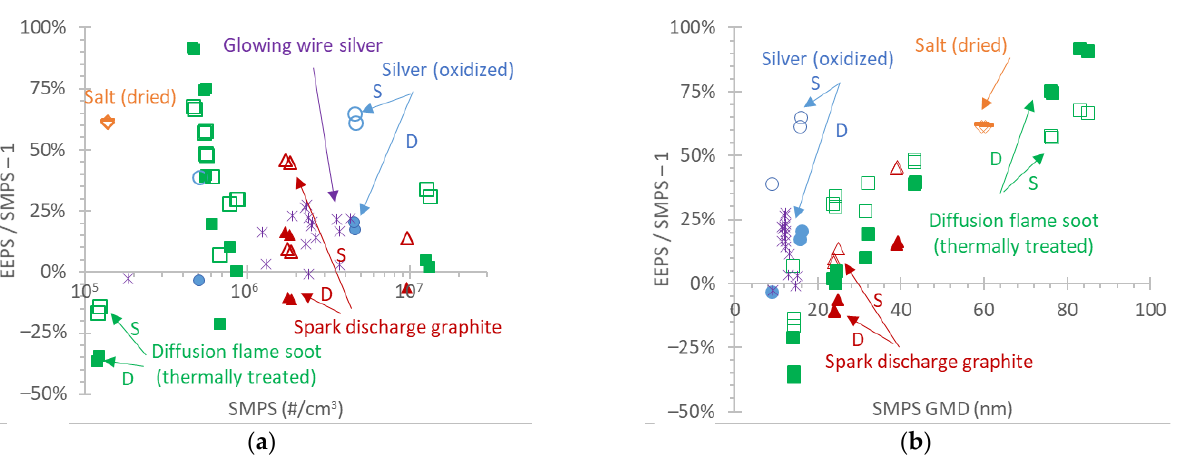
Figure 6. PN concentration ratio (EEPS to SMPS) in function of: ( a ) the SMPS concentration; ( b ) geometric mean diameter (GMD) of SMPS. “D” refers to the “Default” EEPS matrix (solid symbols), “S” refers to the “Soot” EEPS matrix (open symbols). Figure 7a correlates the GMDs of the SMPS and the EEPS with the “Default” (solid symbols) and the “Soot” (o pen symbols) matrices. The slope improved from 0.91 with the